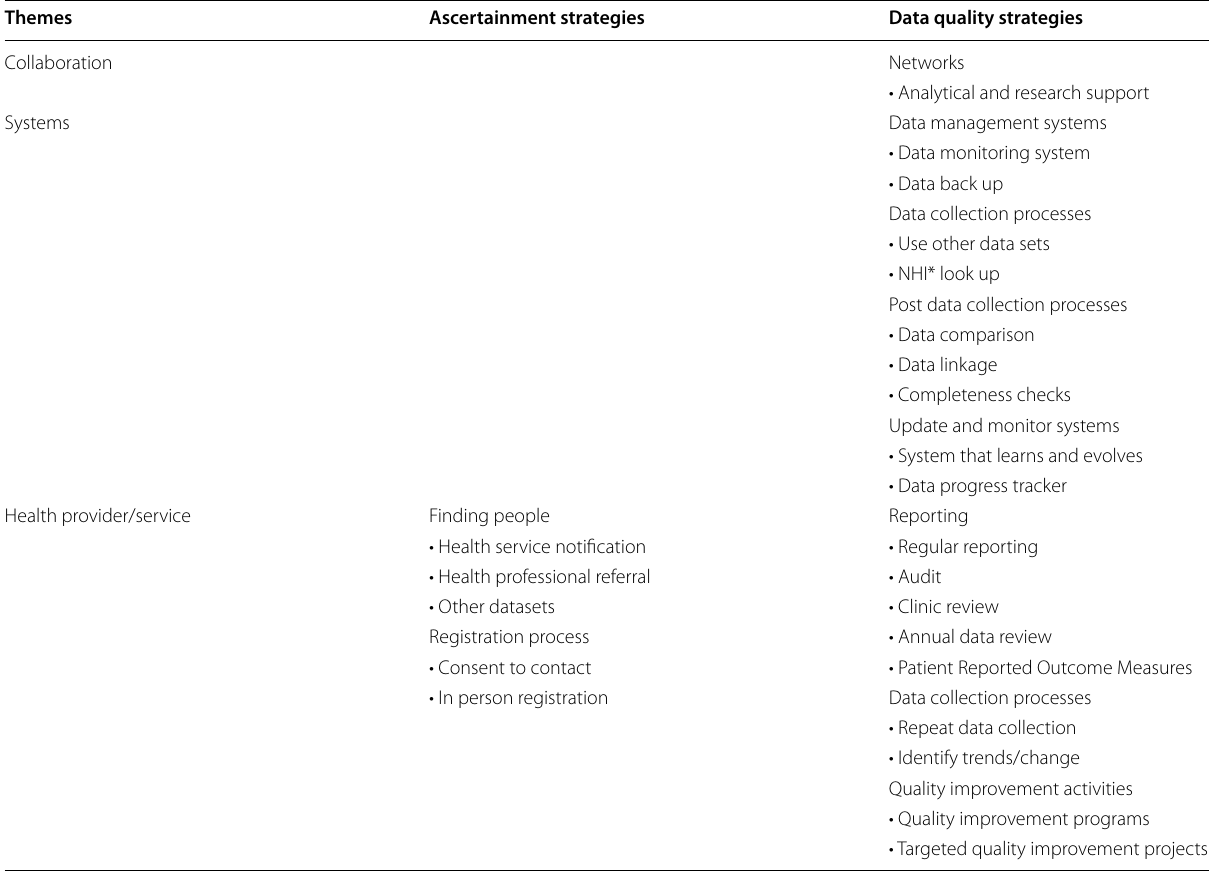
Table 4 Summary table of themes from web scan data strategies to ascertain and support data quality of the target population. Blank spaces indicate no reported